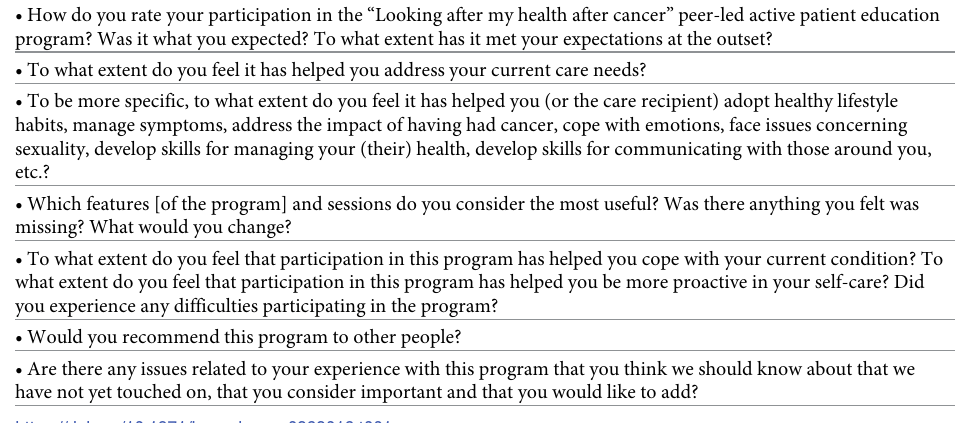
Table 1. Semi-structured guide consisting of open-ended